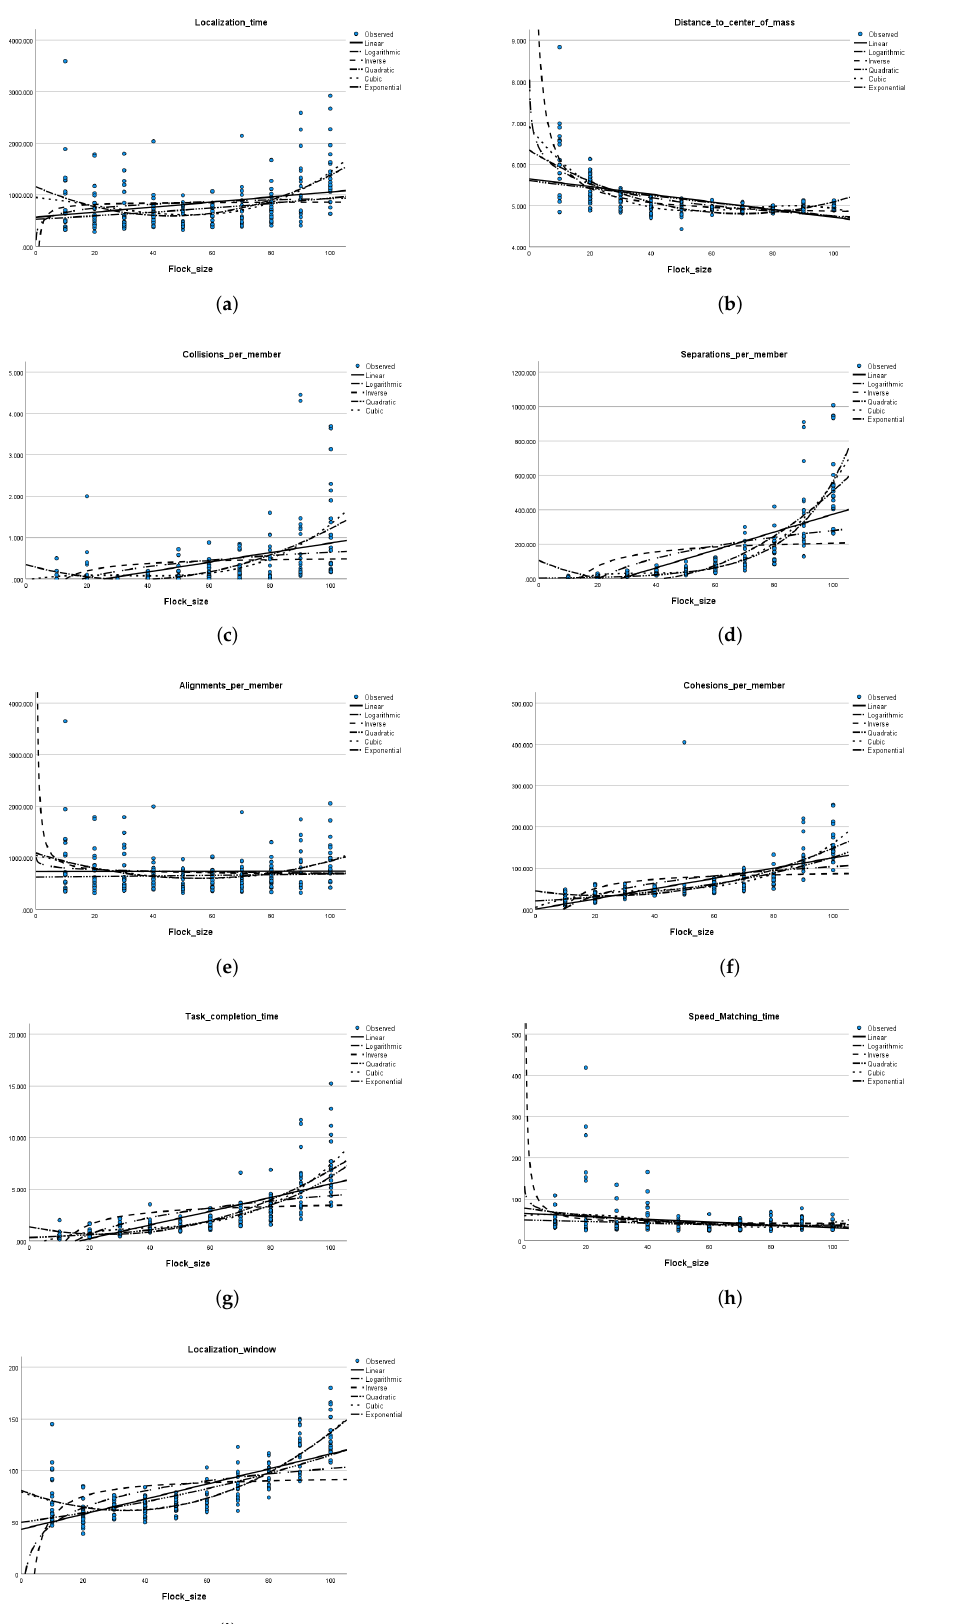
Figure 6. Relationship between the flock size and each of the performance metrics in an environment with obstacles. ( a ) Flock size versus the goal localization time. ( b ) Flock size versus the distance to